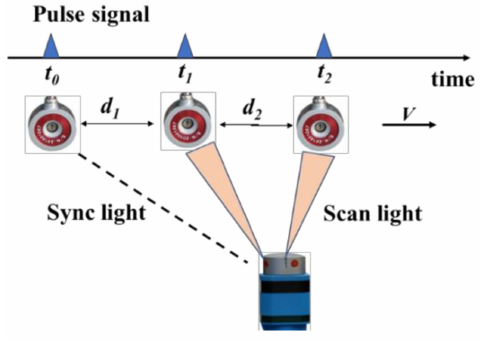
Figure 10. Phase error of dynamic measurement in a single transmitting